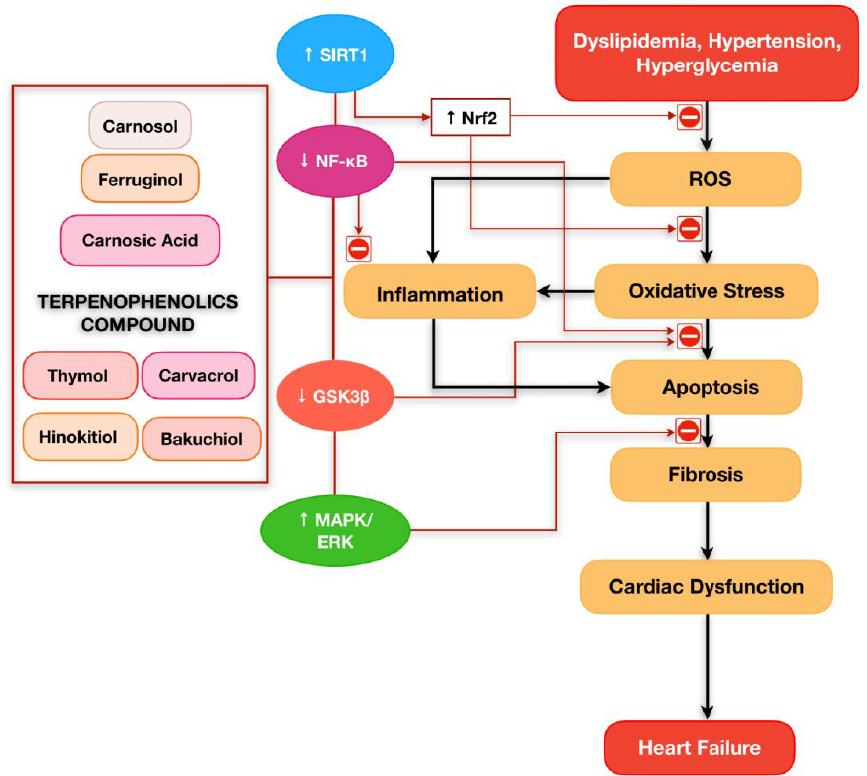
Figure 3. Terpenophenolic compounds exert their potential in attenuating the development of heart failure owing to their ability to counteract reactive oxygen species, oxidative stress, inflammation, apoptosis, and fibrosis via several molecular pathways.